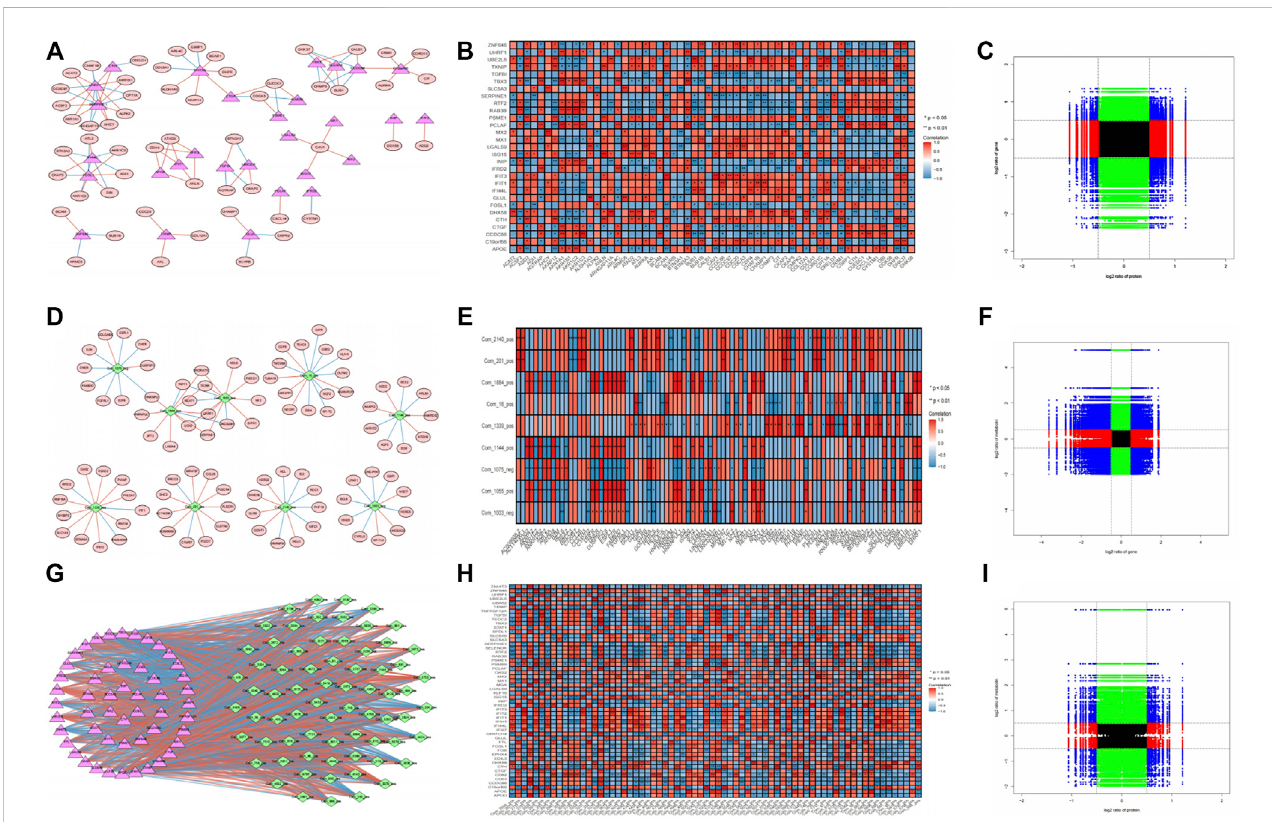
FIGURE 3 Correlation analysis of transcriptome-proteome, transcriptome-metabolome data, and proteome-metabolome data. (A) Interaction network of the DEGs and DEPs with p -value < 0.05, |cor| > 0.8. Red ellipses represent DEGs, pink triangles represent DEPs, red lines represent positive correlations, and blue lines represent negative correlations. (B) Pearson correlation heatmap in transcriptome-proteome analysis. * p < 0.05, ** p < 0.01; Red indicates positive correlation, and blue indicates negative correlation. (C) Nine-quadrant diagram for the transcriptome-proteome correlations. The horizontal axis representsthelog2 ratioofprotein, andtheverticalaxisrepresentsthelog2ratio ofgene. (D) InteractionnetworkoftheDEGsand DEMs with p -value < 0.05, | cor| > 0.8. Red ellipses represent DEGs, green diamonds represent DEMs, red lines represent positive correlations, and blue lines represent negative correlations. (E) Pearson correlation heatmap in transcriptome-metabolome analysis. (F) Nine-quadrant diagram for the transcriptome-proteome correlations. The horizontal axis represents the log2 ratio of gene, and the vertical axis represents the log2 ratio of metabolin. (G) Interaction network of the DEPs and DEMs with p -value < 0.05, |cor| > 0.8. (H) Pearson correlation heatmap in transcriptome-proteome analysis. (I) Nine-quadrant diagram for the transcriptome-proteome correlations. The horizontal axis represents the log2 ratio of protein, and the vertical axis represents the log2 ratio of